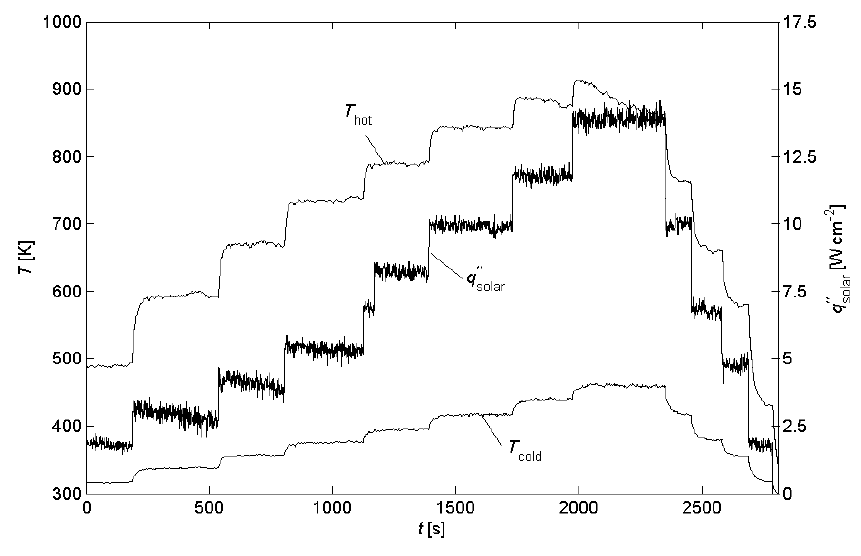
Figure 3. Temperature of hot and cold plates and solar radiative flux as a function of time during a representative experimental run for module with l = 4 mm.